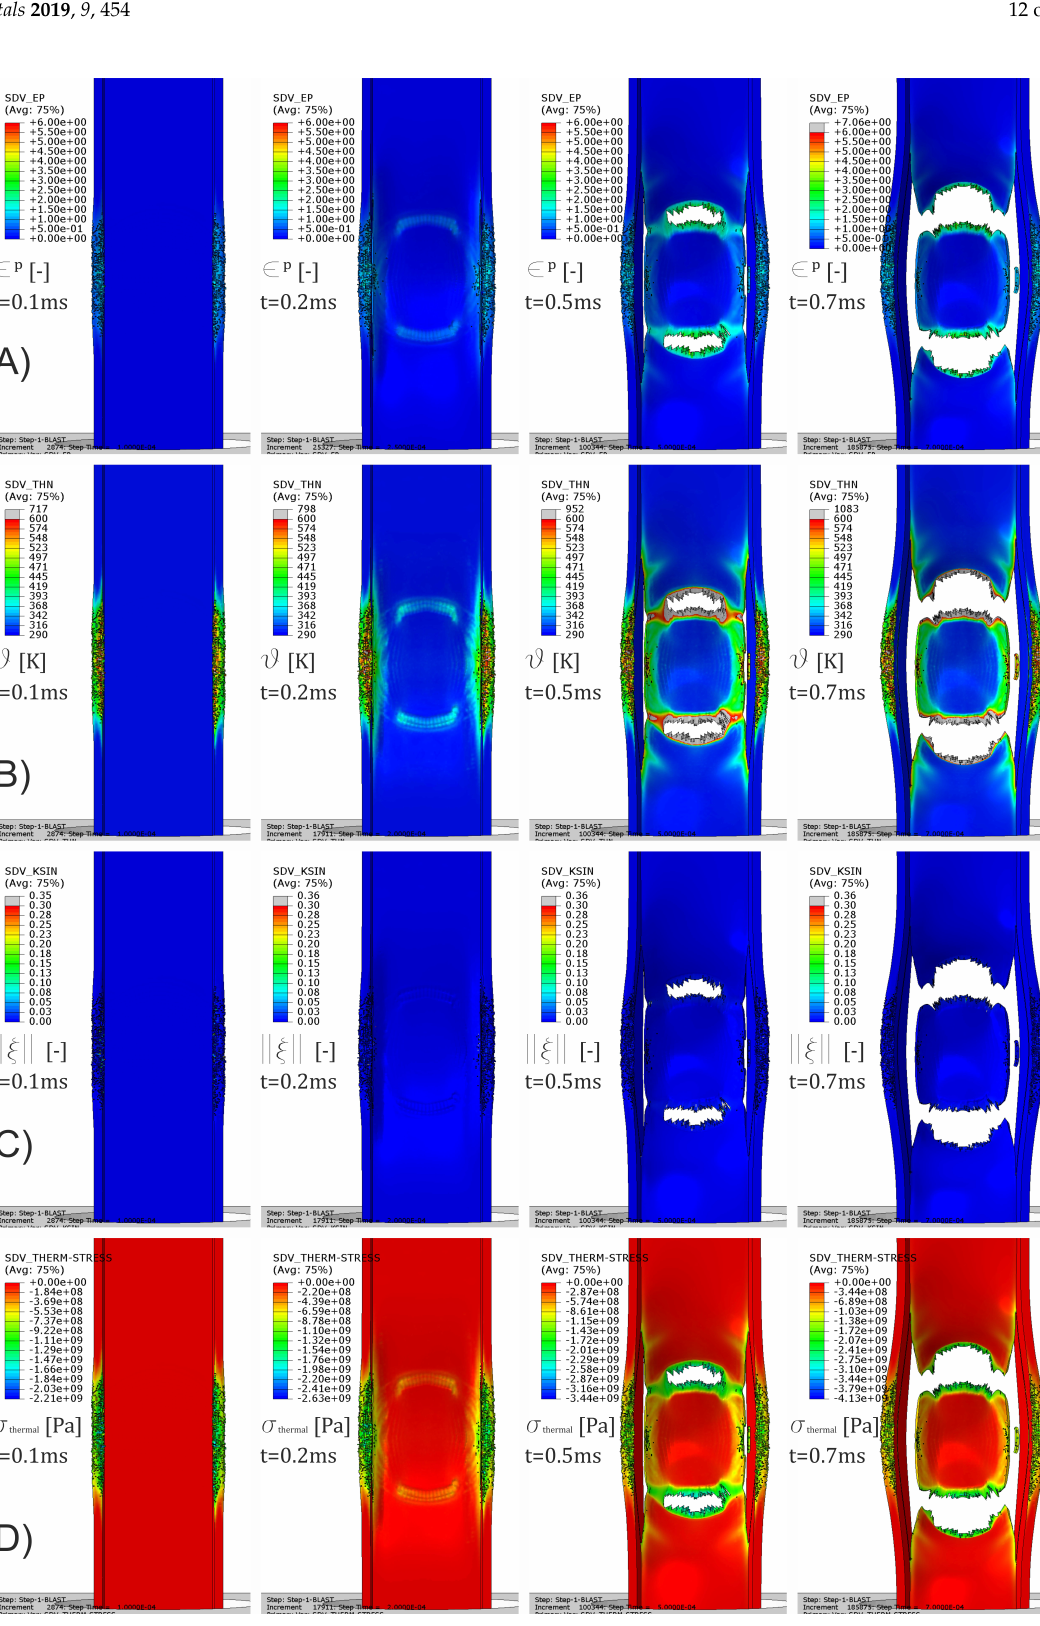
Figure 3. Numerical results: ( A ) Equivalent plastic strains; ( B ) temperature; ( C ) norm of porosity tensor—porosity; ( D ) thermal